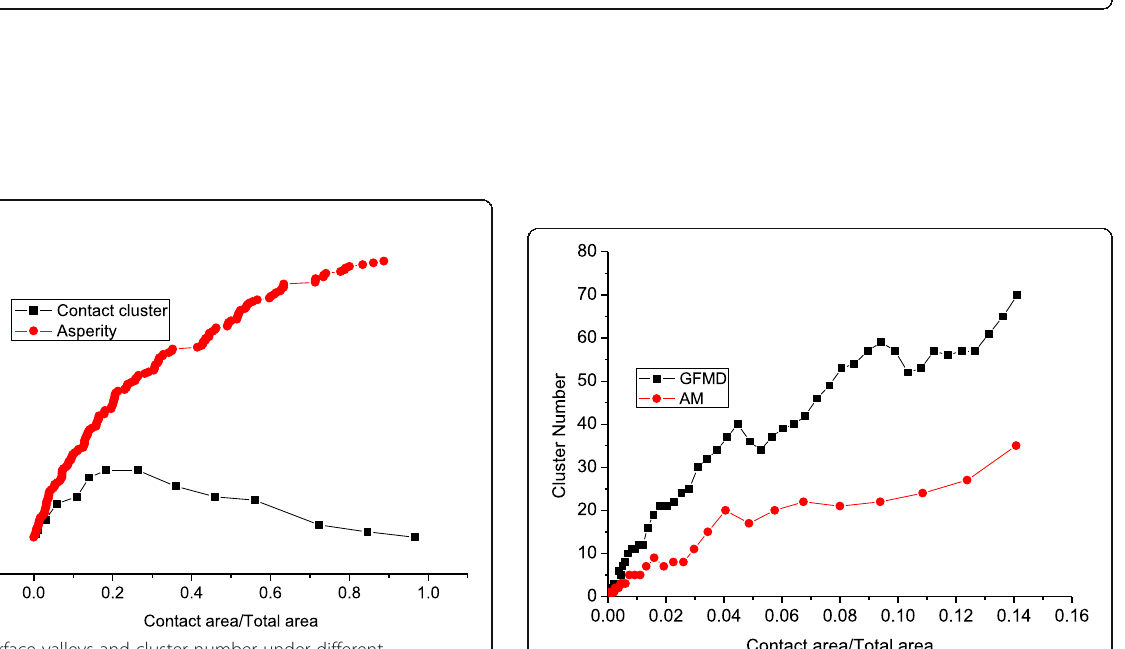
Fig. 3 The shape of the clusters and the merging effect. a The 3D view of contact clusters and its projection on the x - y plane (in σ ). b A typical contact cluster comprising of six independent asperities. c The 3D view of the contact cluster ’ s geometry (in σ )